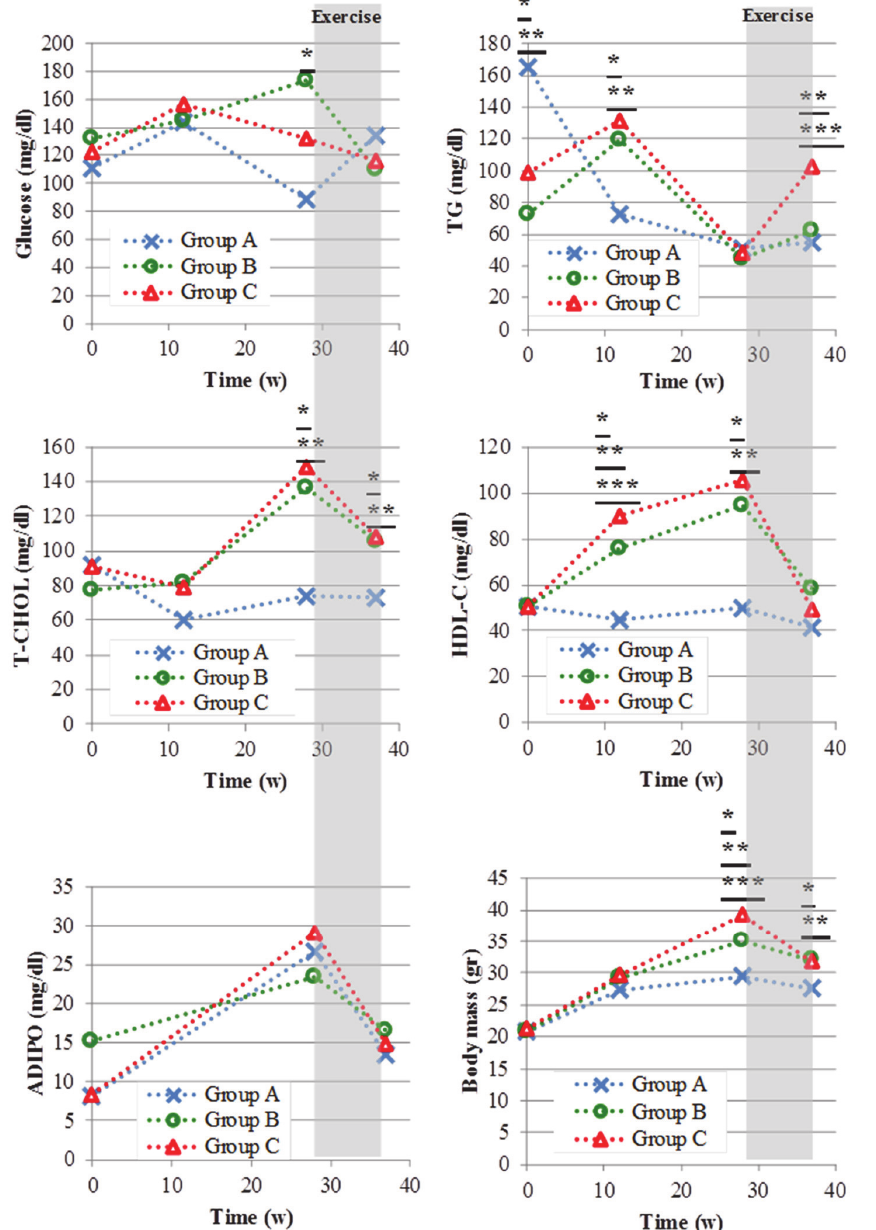
Figure 3: The change in biochemical measures and body mass for the duration of the study. More specifically, biochemical results for the levels of serum glucose, total serum cholesterol (T-CHOL), high-density lipoprotein cholesterol (HDL-C), serum triglycerides (TG) and serum adiponectin levels (ADIPO) are presented. Statistically significant differences (i.e. p<0.05) between groups A and B, A and C and between groups B and C are noted using *, ** or *** respectively. The time period when group C was exposed to exercise (i.e. weeks 28-37) is also